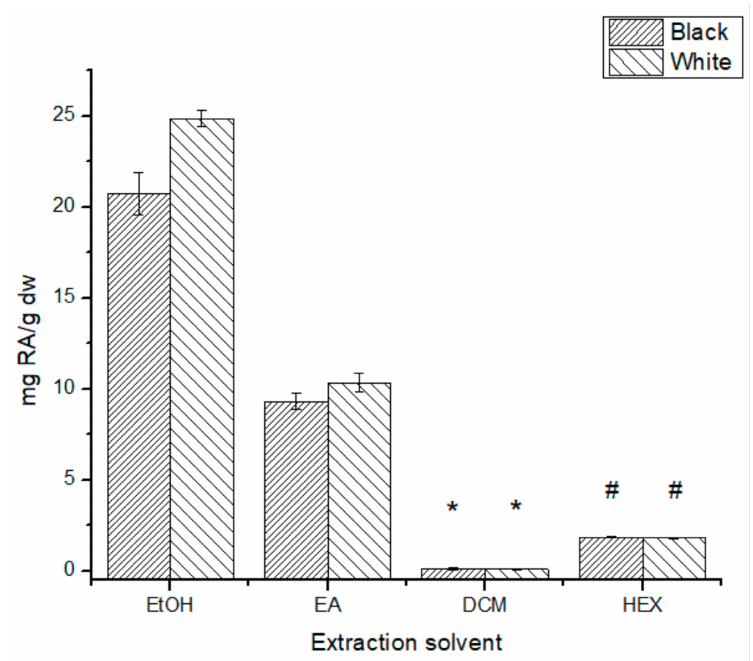
Figure 7. Rosmarinic Acid content for all extracts tested. *, # No significant difference ( p >